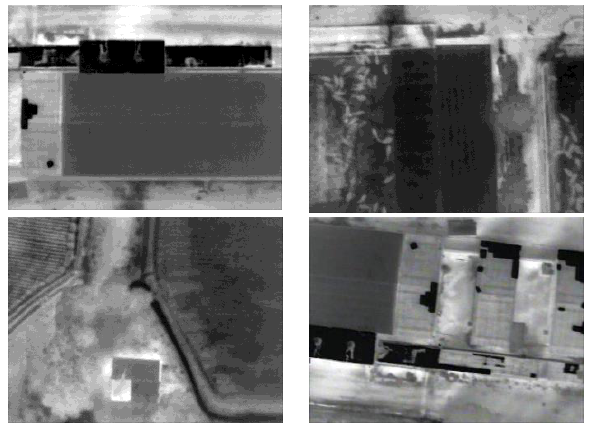
Figure 7: Frame extracted from thermal video